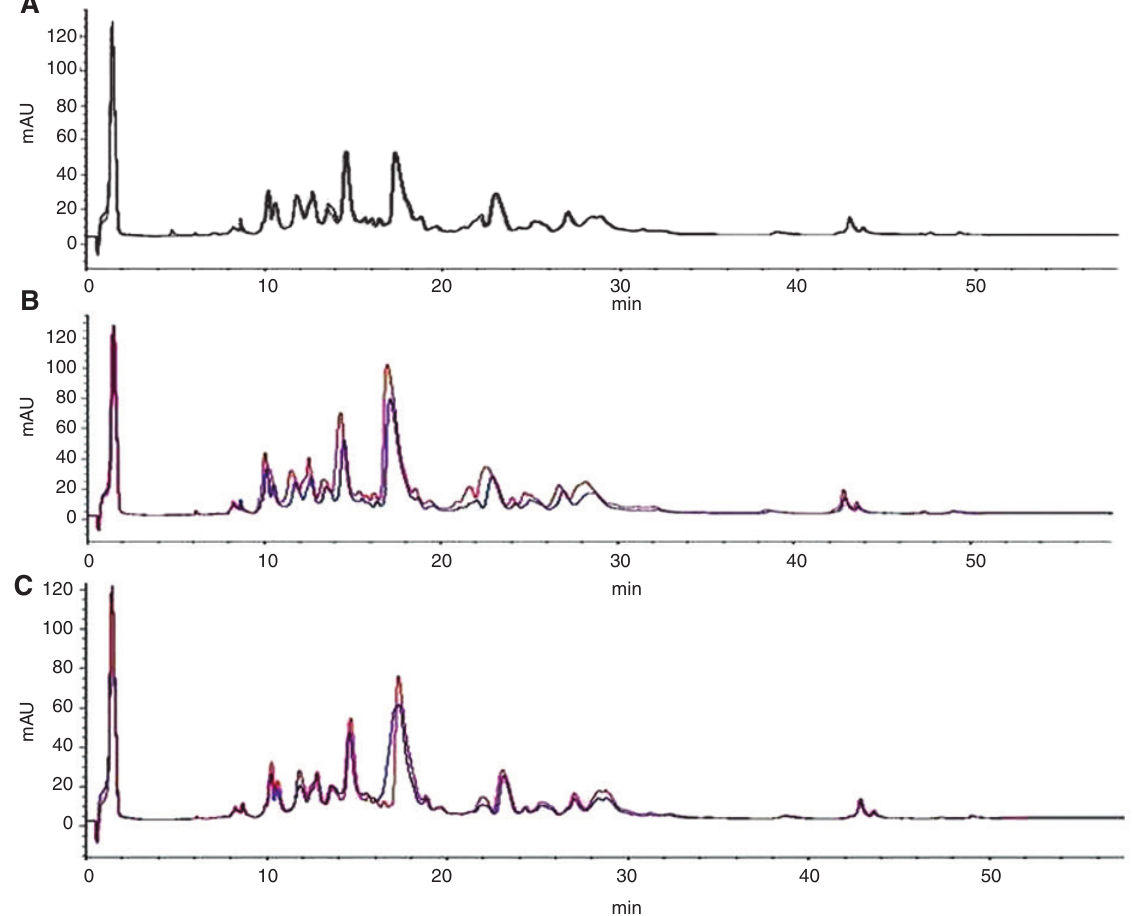
Figure 1: HPLC separation curves from patient plasma before (blue) and after (red) dialysis treatment in three modalities, by hemofiltration (HF) in (A), hemodialysis (HD) in (B) and hemodialfiltration (HDF) in (C). As shown, effects of the separate dialyses